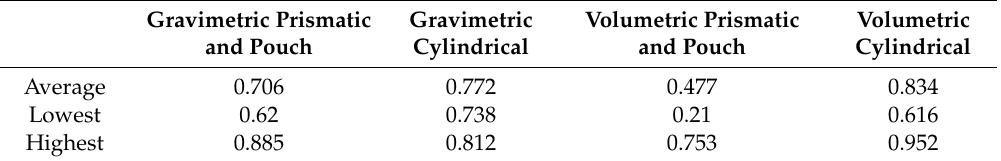
Figure 9. Scaling trend of energy density on module level vs. energy density on system level. Table 3. Efficiency rate of module to system level.